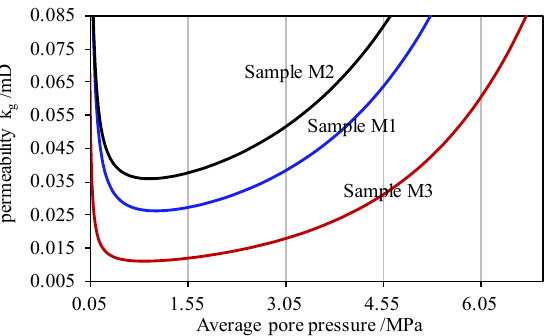
Figure 7. Comparison between the experimental data and model calculation. ( a ) Sample M1, ( b ) Sample M2, ( c ) Sample M3. Figure 8. Permeability model calculation results under a hydrostatic stress of 8 MPa.